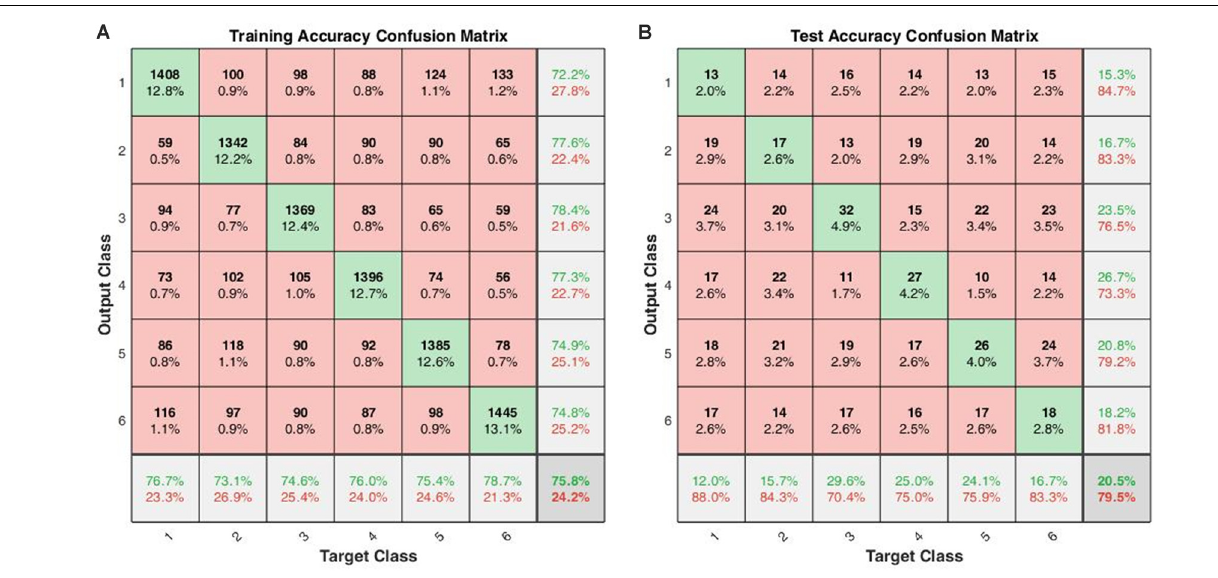
FIGURE 5 | Across-subject classification accuracies (leave-one-out validation of the LSTM with 16 hidden layers): (A) confusion matrix for training, (B) confusion matrix for testing (Class 1: English; Class 2: non-English; Class 3: Nature sound; Class 4: Music; Class 5: Annoying sound; Class 6: Gunshot).